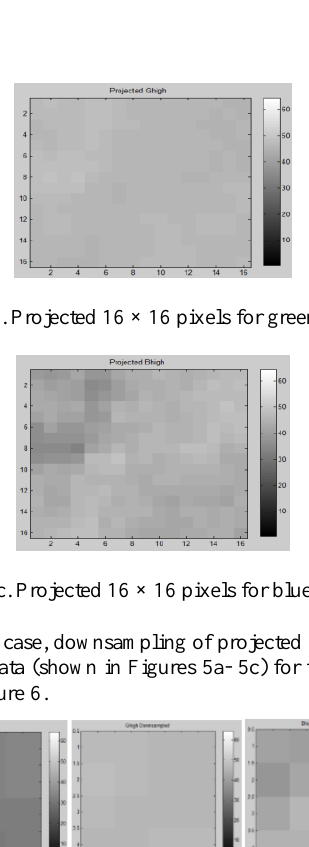
Figure 3c Projected 16 ×16 pixels blue channel